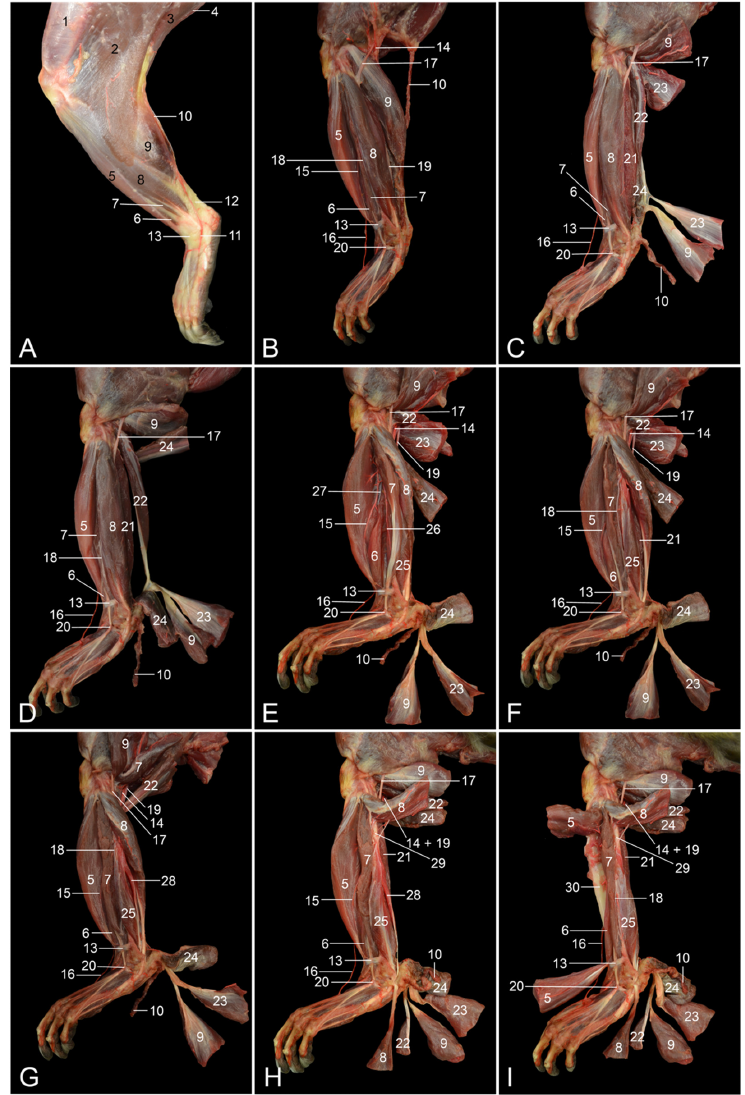
Figure 7. Lateral views of the left lower hindlimb. ( A ) Superficial layer with the superficial venous system filled with red latex; ( B ) second layer after the m. biceps femoris was retracted; ( C ) third layer after the m. gastrocnemius caput laterale, the m. gastrocnemius caput mediale and the v. saphena lateralis were transected and retracted; ( D ) fourth layer after the m. soleus was transected and the stumps were retracted; ( E ) fifth layer after the m. plantaris was transected and the stumps were retracted; ( F ) sixth layer after cranial retraction of the m. extensor digitorum longus and the m. fibularis brevis; ( G ) seventh layer after the m. fibularis longus and the m. fibularis brevis were separated; ( H ) eighth layer after the m. fibularis longus was transected and the stumps were retracted; ( I ) deepest layer after the m. tibialis cranialis was transected and the stumps were retracted. 1: Fascia lata; 2: m. biceps femoris; 3: m. semitendinosus; 4: m. semimembranosus; 5: m. tibialis